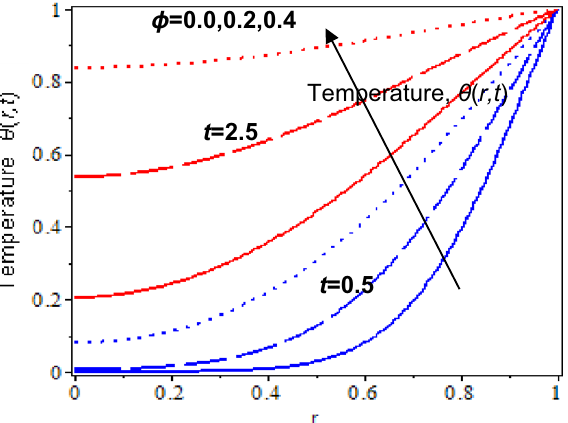
Figure 11. Nanofluid temperature with various nanoparticles volume fraction and time parameter.